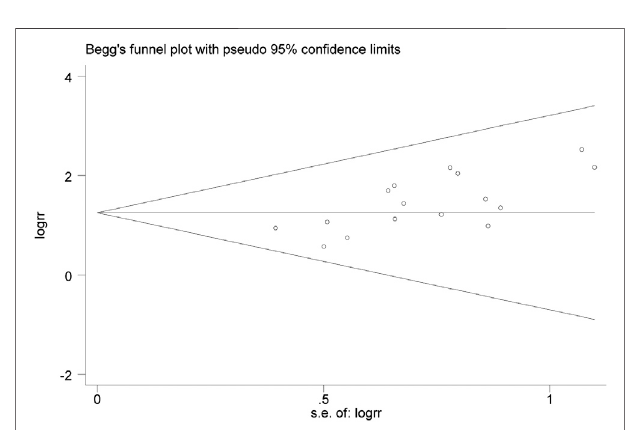
FIGURE 9 | Begg ’ s funnel plot of the total effective rate. SSYX-amiodarone vs. amiodarone.